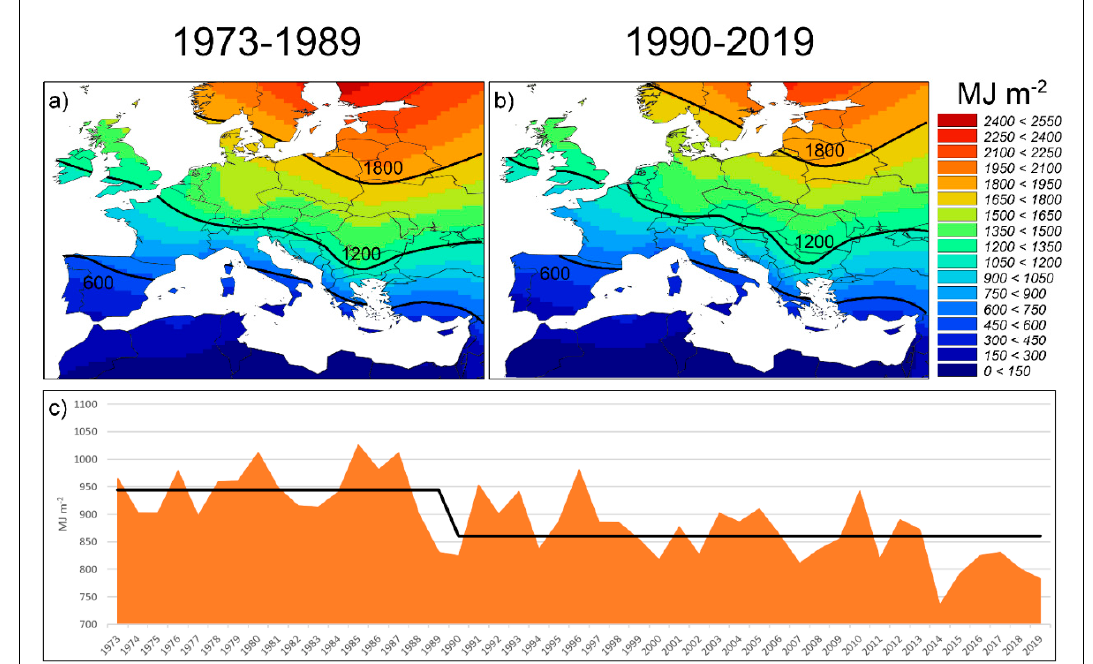
Figure 3. ( a ) Average yearly heating requirements for the period 1973 − 1989, ( b ) average yearly heating requirements for the period 1990 − 2019, ( c ) yearly requirements from 1973 to 2019 (average of the 56